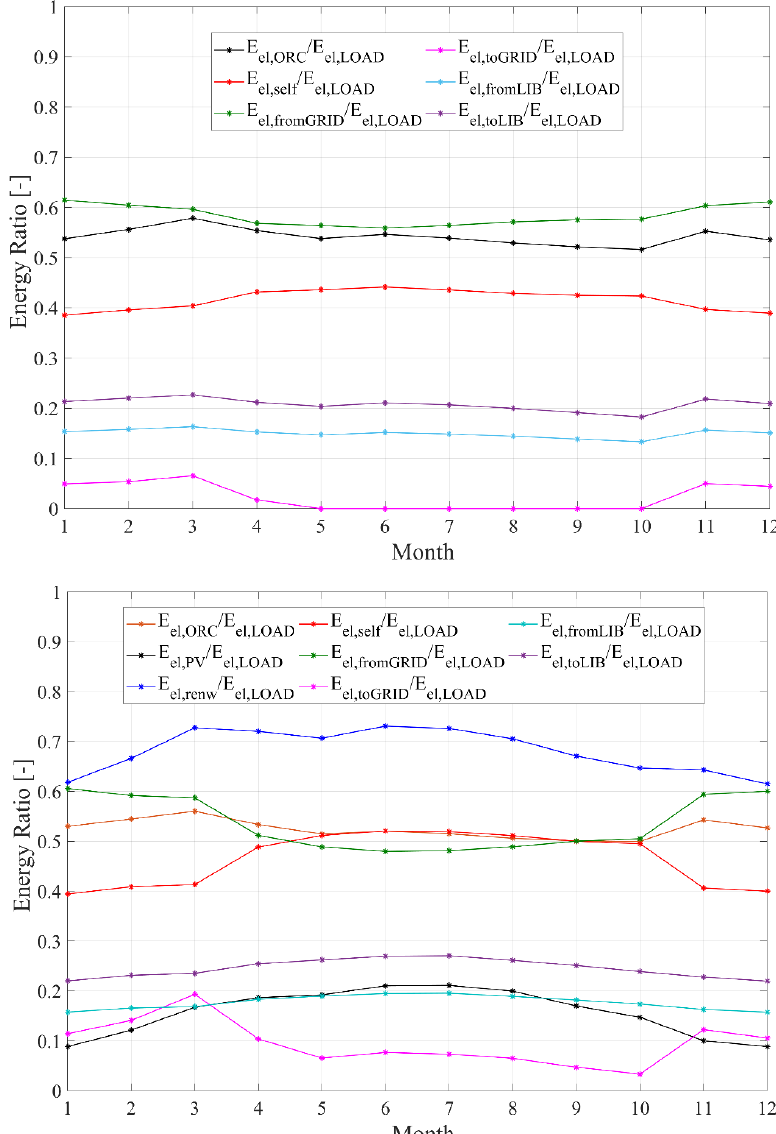
Figure 6. Monthly results, electric performance: Case ETC ( above ) and Case PV ( below ).